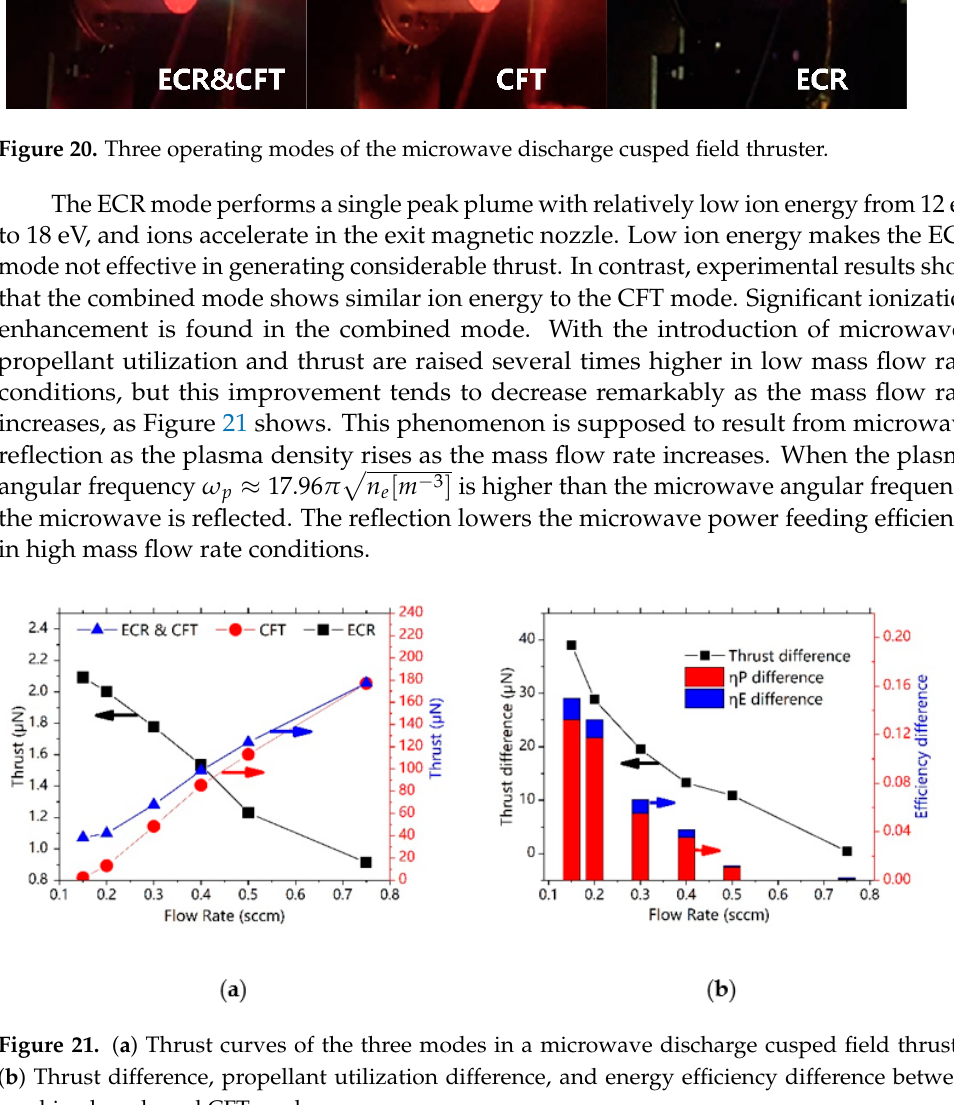
Figure 20. Three operating modes of the microwave discharge cusped field thruster.